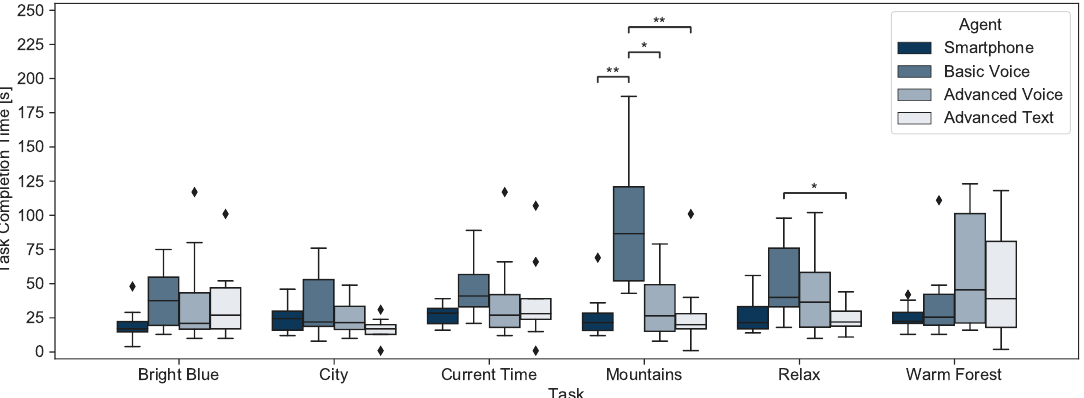
Figure 7. Task completion time per task and agent during Part II. Note: * p < 0.05, ** p < 0.01, *** p < 0.001. Table 3. Mean task completion time and mean number of interactions per task and agent during Part II of the experiment. Values are reported in percent, normalized to the task completion time and the number of interactions of SA , respectively. SA = Smartphone Application, BV = Basic Voice, AV = Advanced Voice, AT = Advanced Text